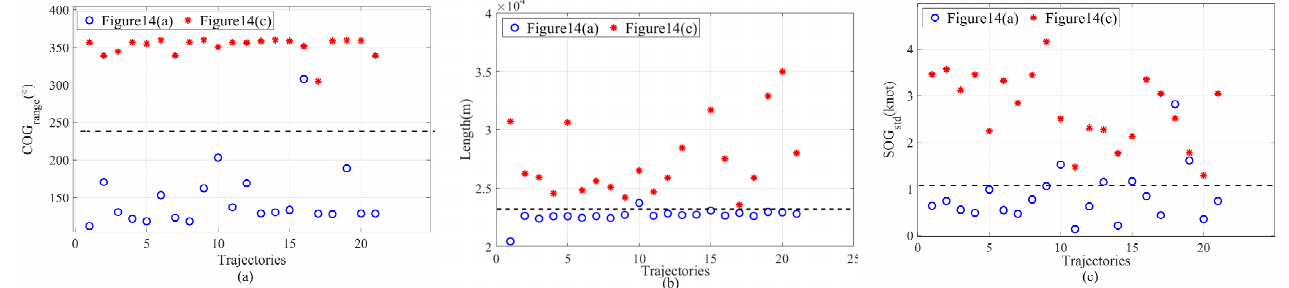
Figure 15. Trajectory feature comparison between Figure 14a,c. ( a ) feature comparison considering COG range ; ( b ) feature comparison considering trajectory length; ( c ) feature comparison considering SOG std